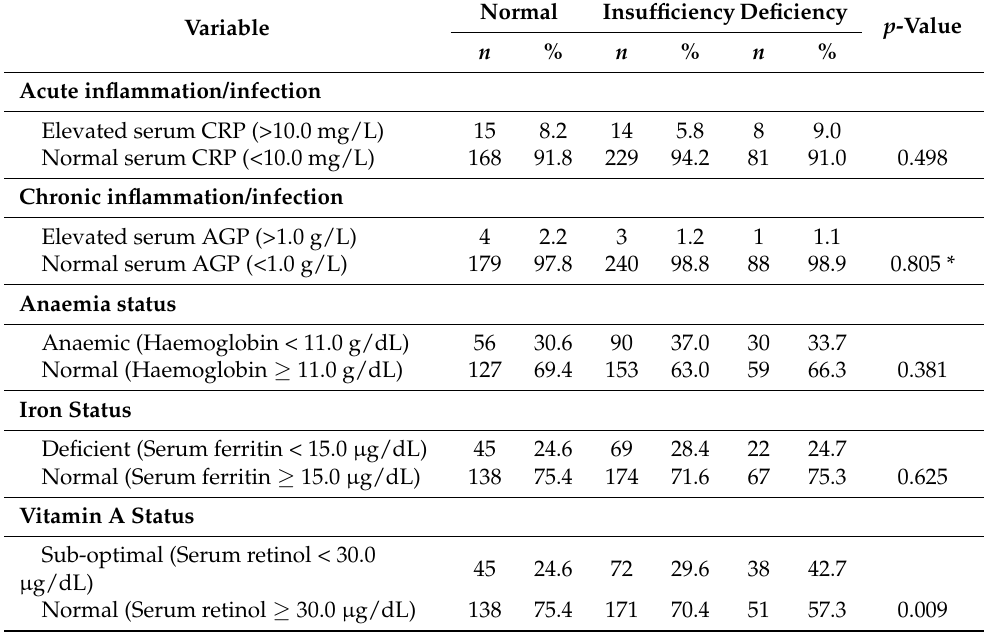
Table 4. Differences in the prevalence of vitamin D deficiency and insufficiency among pregnant rural